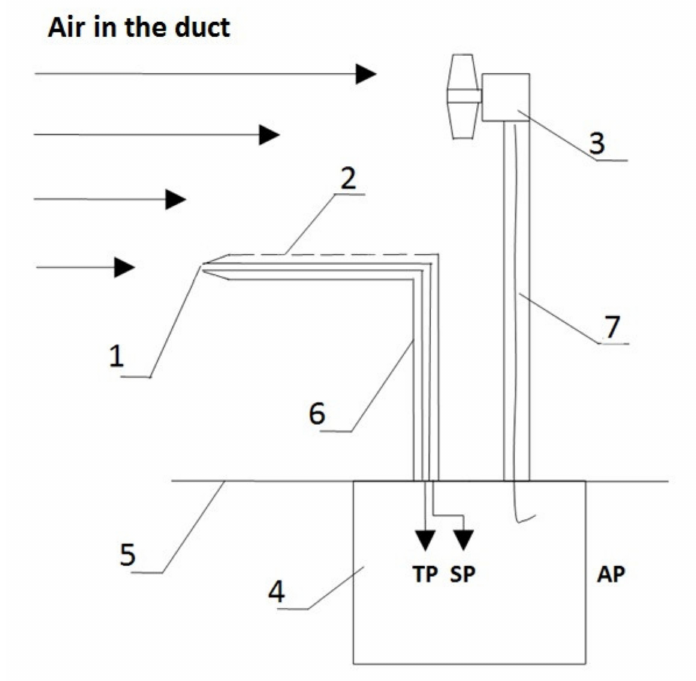
Figure 4. Simplified diagram of the measuring module: 1—inner channel of the Prandtl tube, 2—the opening of the outer Prandtl tube, 3—turbine with a power generator, 4—measuring transducer with a trans receiver module, 5—cable wall, 6—Prandtl measuring tube, 7—electric wire, TP—total pressure, SP—static pressure, AP—atmospheric